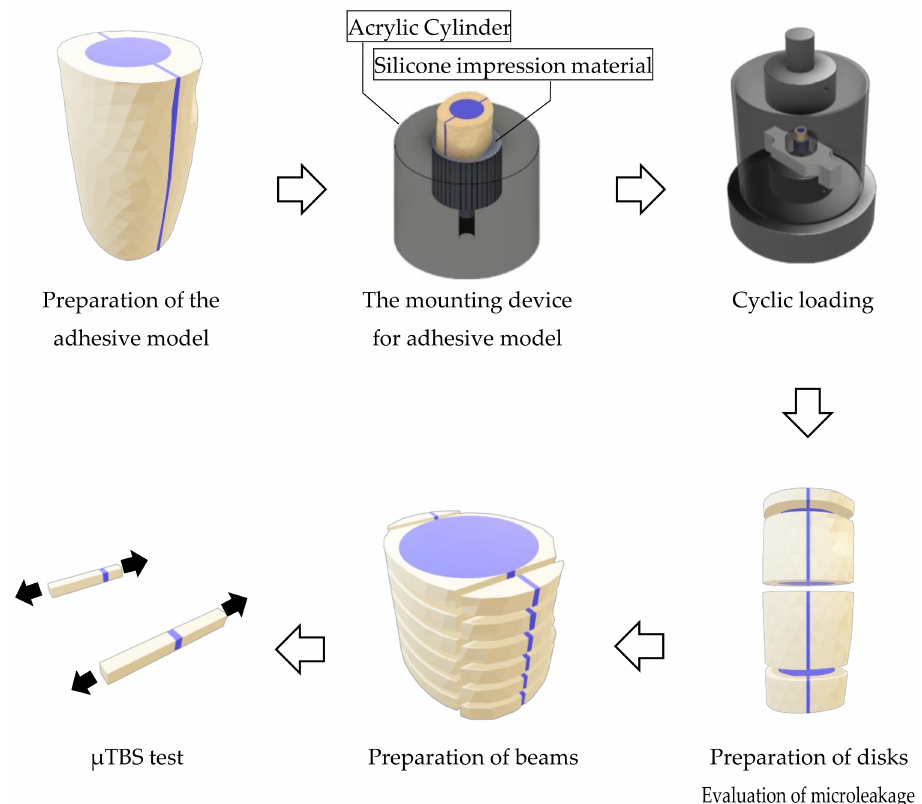
Figure 2. Procedures for using the adhesive